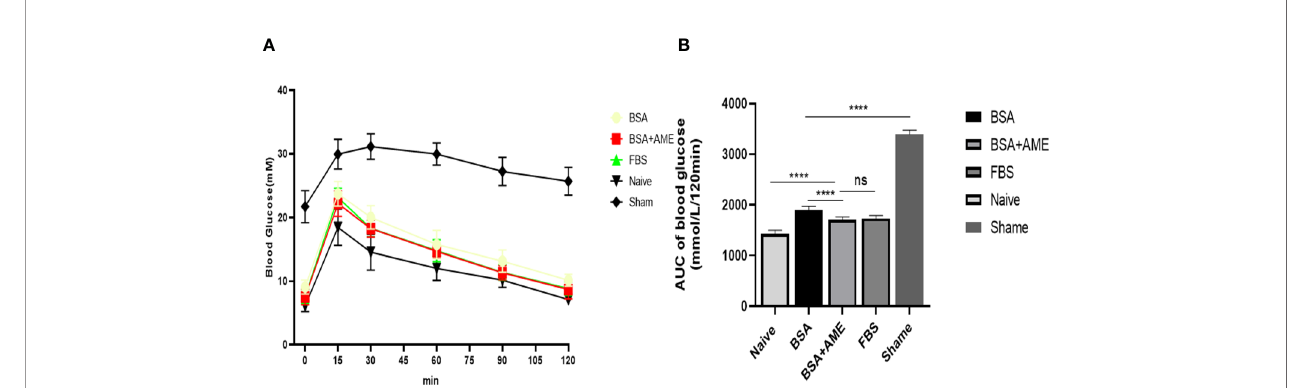
FIGURE 7 | Intraperitoneal glucose tolerance test of islet grafts pre-cultured under different conditions (A) . Blood glucose was measured at 0, 15, 30, 60, 90, and 120 min after dextrose I.P. administration. Data points are shown as mean ± SD (B) . Areas under the curve of blood glucose tolerance test, expressed as